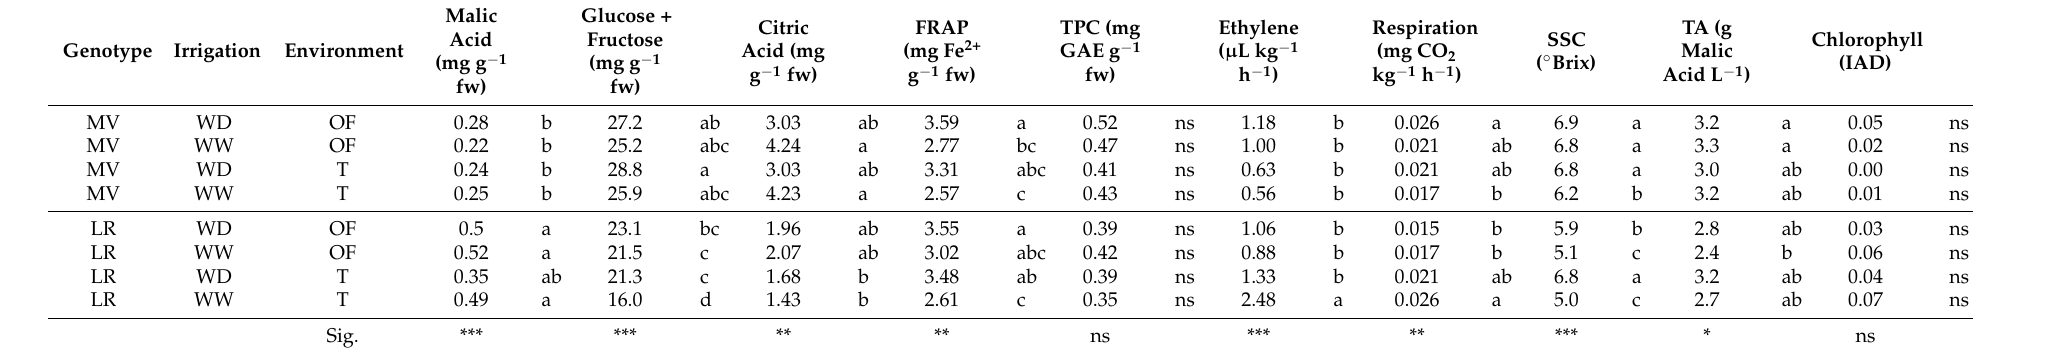
Table 2. Effect of water regime (water deficit, WD; well-watered, WW) and growing environment (open field, OF; tunnel, T) on fruit’s chemical characteristics of two Penjar genotypes (landrace, LR; modern cultivar, MV) at harvest. Within columns, data indicated with different letters are significantly different ( p < 0.05). Significance of the ANOVA for each variable is shown on the bottom line (significance levels: * <0.05, ** <0.01, *** <0.001, ns = not